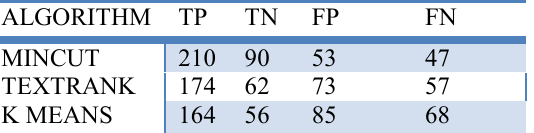
Table 1. Confusion matrix value for three algorithms